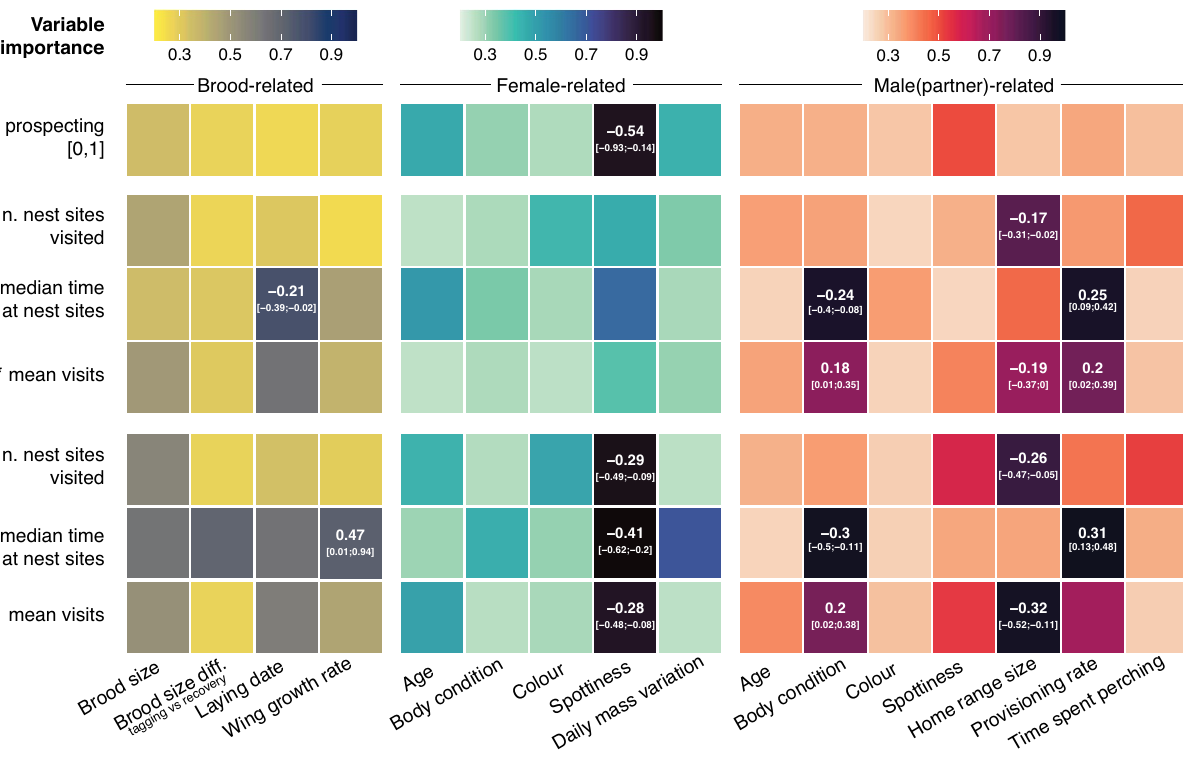
Figure 2. Summary of 21 averaged models (binomial, tweedie and negative binomial GLMMs) displaying the response variables on the y-axis and predictors on the x-axis. The response variables with a preceding “asterisk” include only females that visit other nest sites during their tracking period. Tile colour refers to variable importance derived from model averaging (see “Methods” for detailed explanation). The three different colour palettes highlight the three different set of predictors related with their breeding and brood in yellow to blue, the tracked female in blues, the male partner in red to dark purple. Estimate coefficients and 95% confidence intervals (C.I.) are reported when C.I. do not overlap 0, indicating moderate to strong evidence of the effects reported 62,63